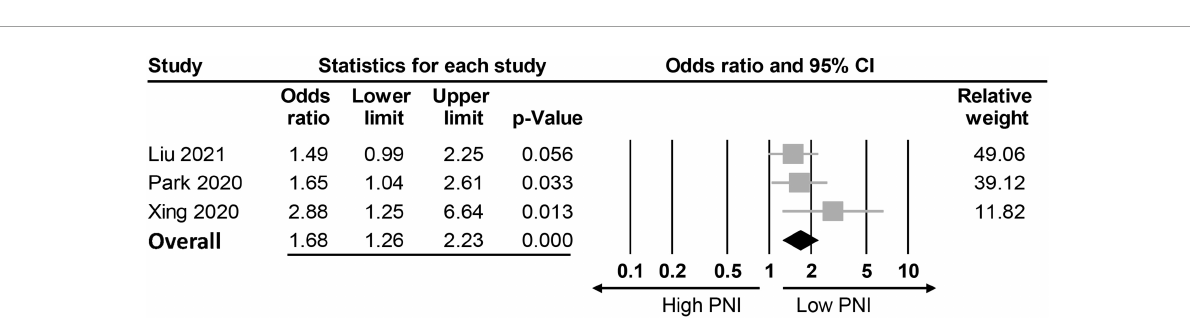
FIGURE5 Forest plot showing a negative association between risk of postoperative delirium (POD) and prognostic nutritional index (PNI) (Cut-off values: 50) (OR: 1.68, 95% CI: 1.26–2.23, p < 0.0001, I 2 = 0%). CI, confidence